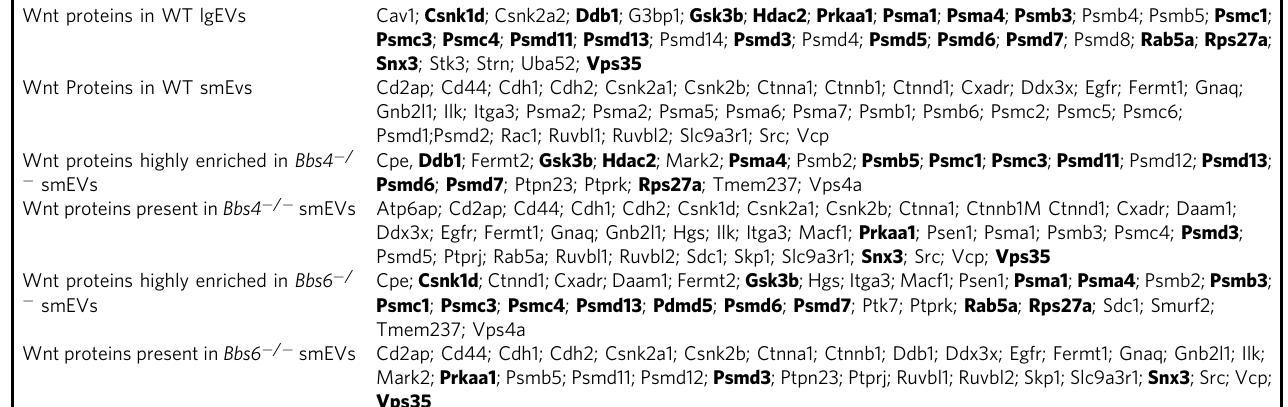
NATURE COMMUNICATIONS| (2021) 12:5671